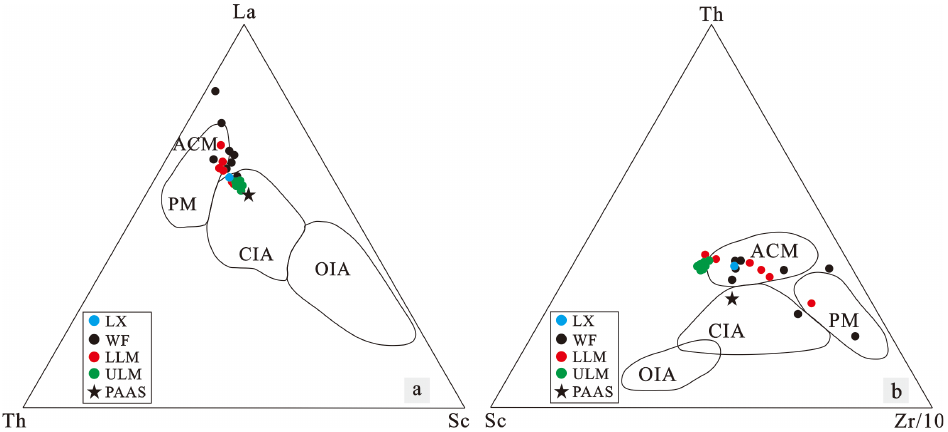
Figure 5. ( a ) La – Th – Sc and ( b ) Th – Sc – Zr/10 ternary diagrams (modified from Ge et al., 2019 [38]) showing mainly active continental margin tectonic settings. Note: OIA, CIA, ACM, and PM are the abbreviations for the oceanic island arc, continental island arc, active continental margin, and passive margin, respectively.